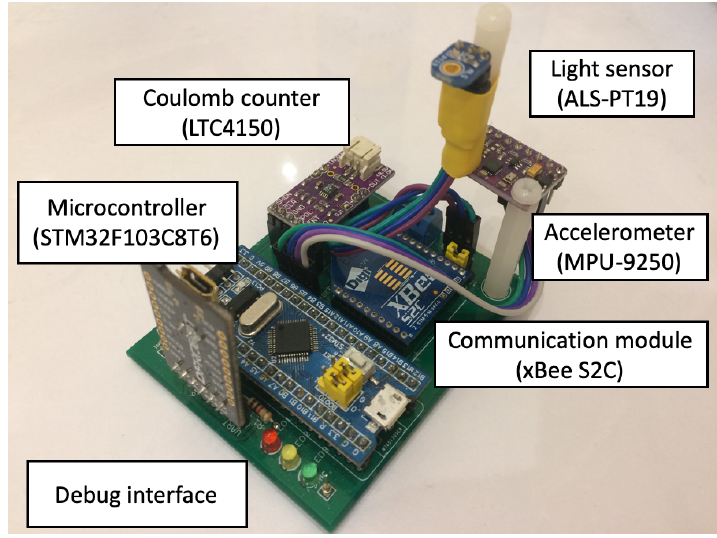
Figure 4. Sensor